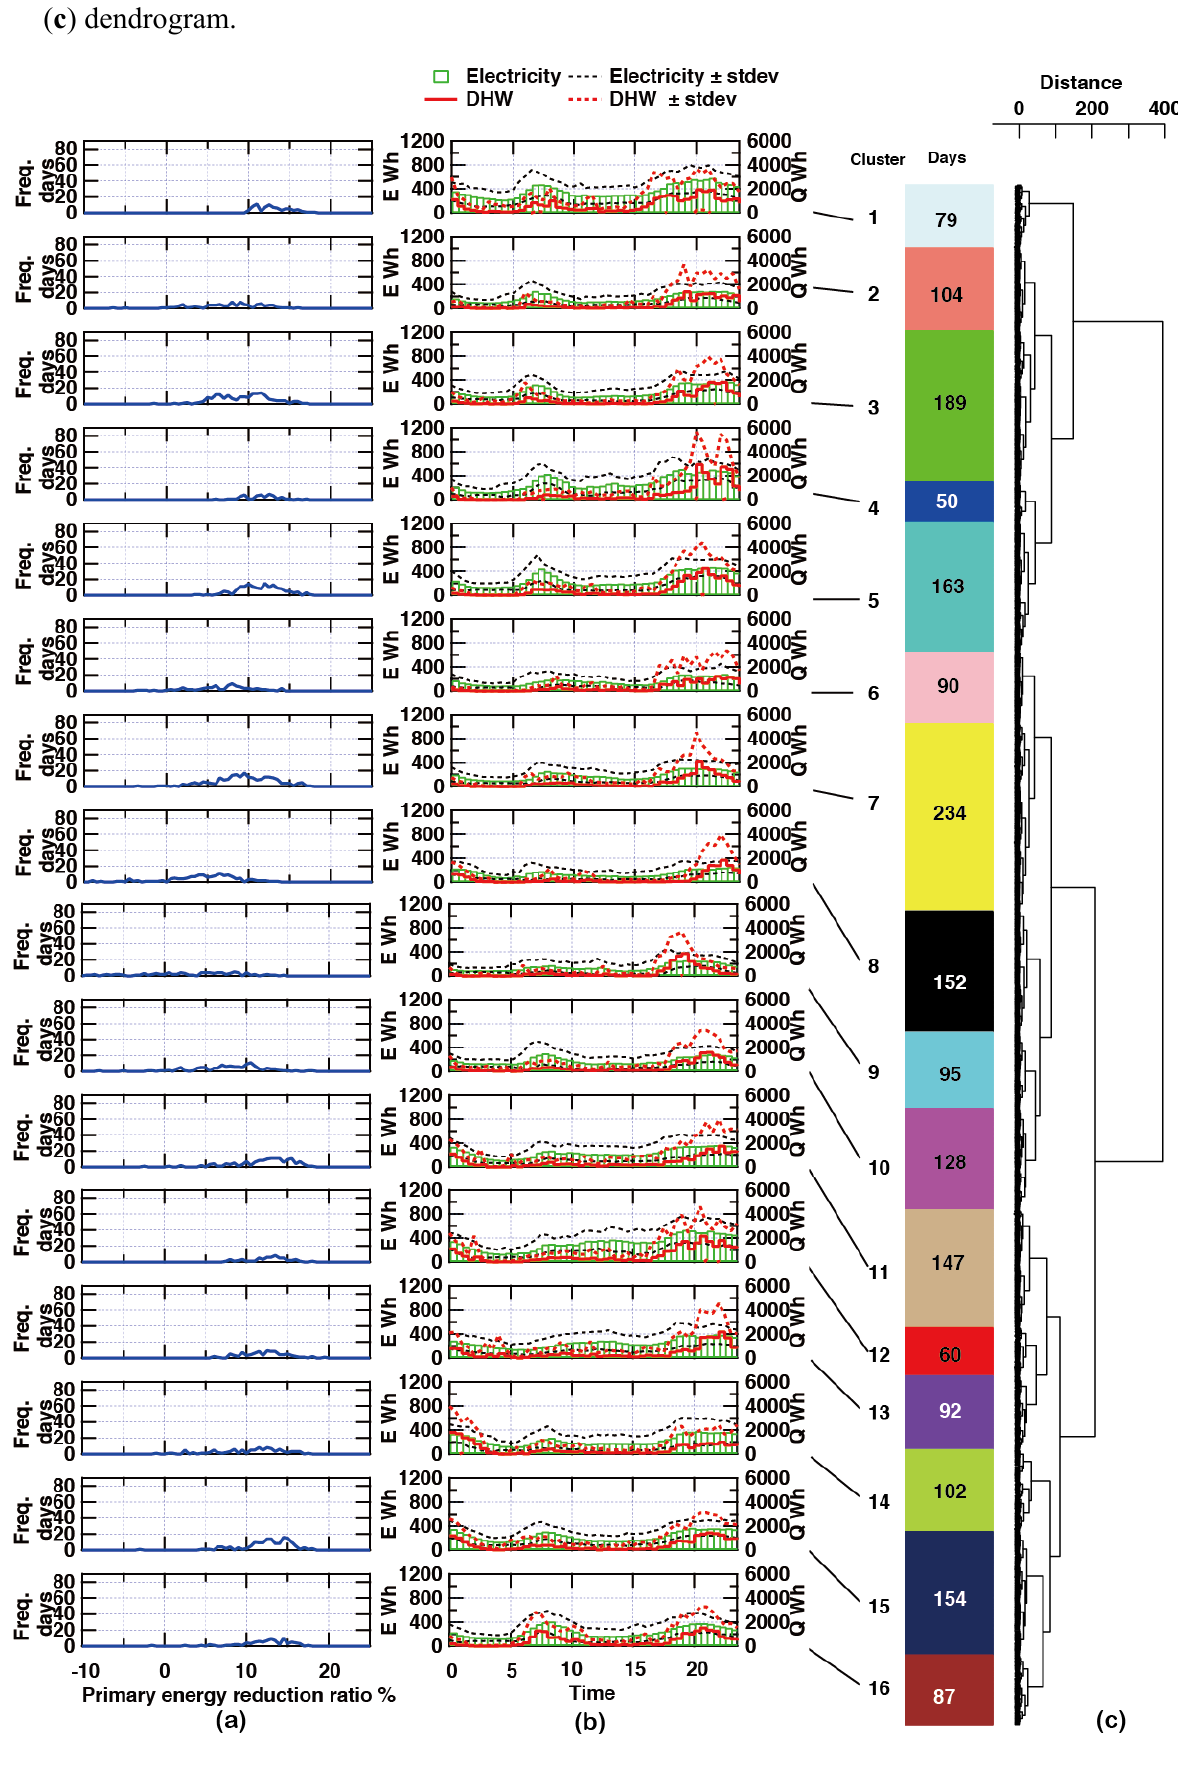
Figure 12. Clusters in Group E. ( a ) primary energy reduction ratio; ( b ) demand patterns; ( c )